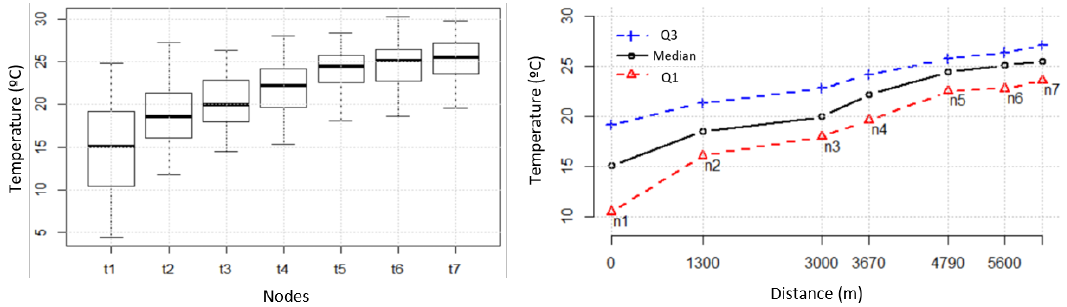
Figure 1. Effective temperature measurements in each node (left) and as a function of distance